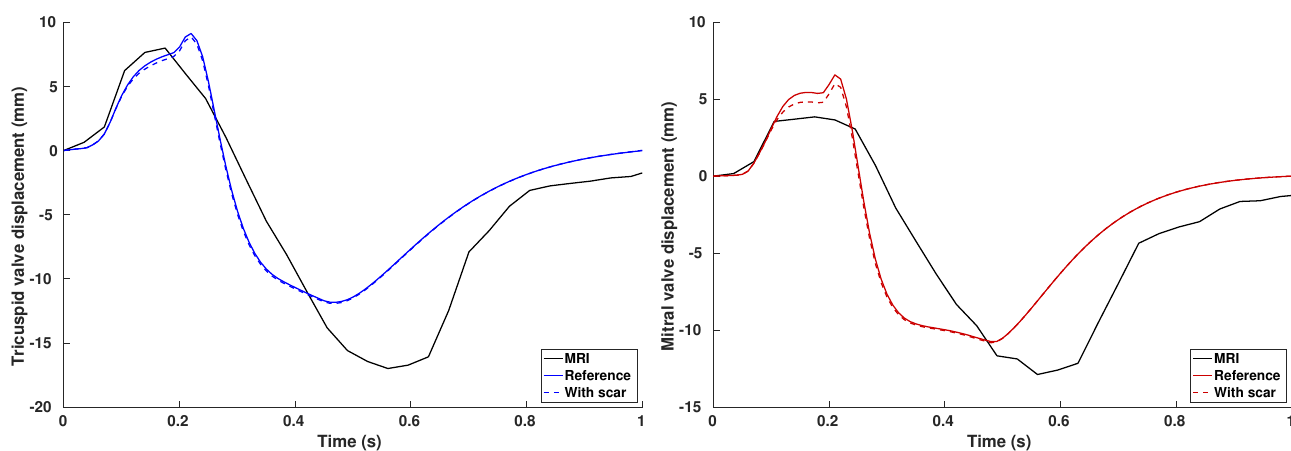
Figure 12. Atrioventricular plane displacement from imaging data (dashed line) and numerical simulation (solid line). Starting from the last cycle of the control heart beat simulation, an ablation scar was introduced in the left atrium. It took three heart cycles for the volumes in the circulatory system to adapt to the new conditions and to reach a limit cycle with a stroke volume